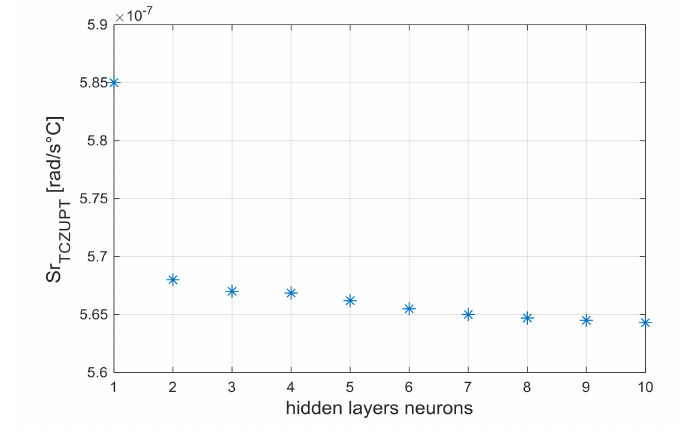
Figure 8. Performance parameter Sr TCZUPT vs. number of hidden layers neurons (TCZUPT